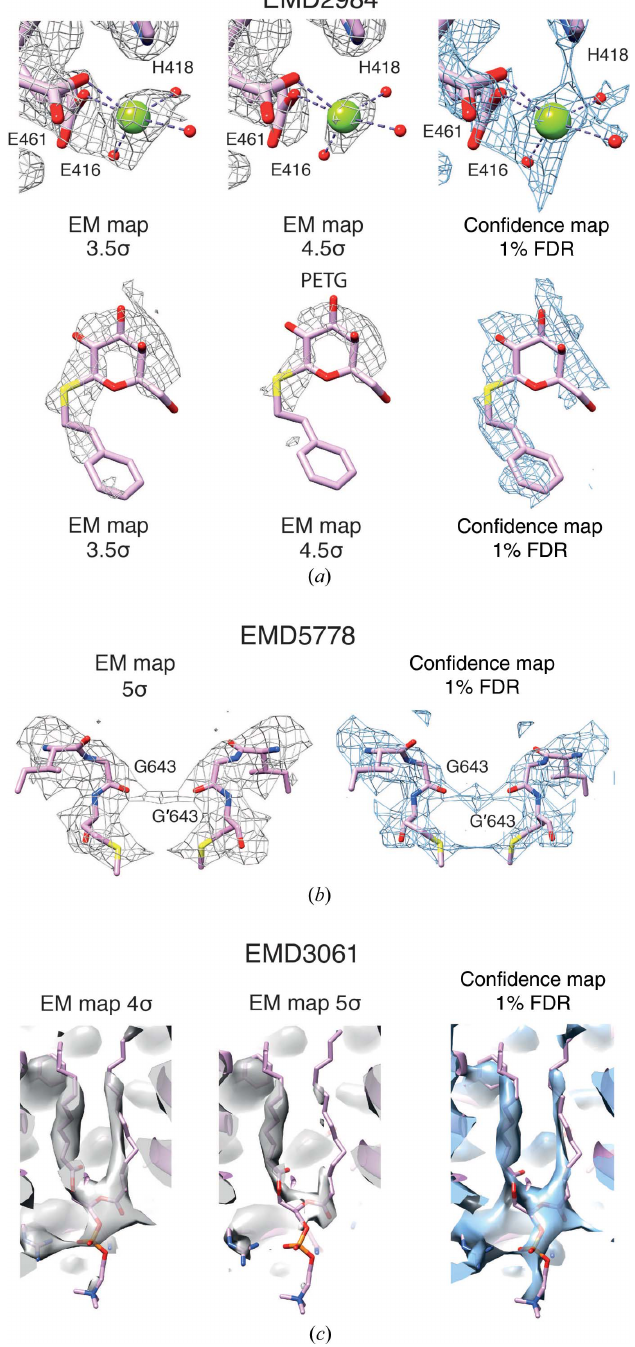
Figure 6 Confidence maps confirm the localization of nonprotein components. ( a ) (cid:5) -Galactosidase (EMD-2984) with 3.5/4.5 (cid:2) -thresholded cryo-EM maps (left and center, gray) and a 1% FDR-thresholded confidence map (right, blue). Top: the Mg 2+ ion is coordinated by Glu461, Glu416, His418 and three H 2 O molecules. Bottom: density of bound PETG ligand in 3.5/4.5 (cid:2) - thresholded cryo-EM maps and the 1% FDR confidence map. ( b ) TRPV1 channel (EMD-5778) with a 5 (cid:2) -thresholded cryo-EM map (left) and a 1% FDR-thresholded confidence map (right): the selectivity filter formed by the carbonyls of symmetry-related Gly643 residues. The presence of a putative ion is supported by the confidence map. ( c ) (cid:4) -Secretase (EMD- 3061) with 4 (cid:2) - and 5 (cid:2) -thresholded cryo-EM maps (left) and a 1% FDR- thresholded confidence map (right). The confidence map reveals density for both acyl chains of phosphatidylcholine at a single